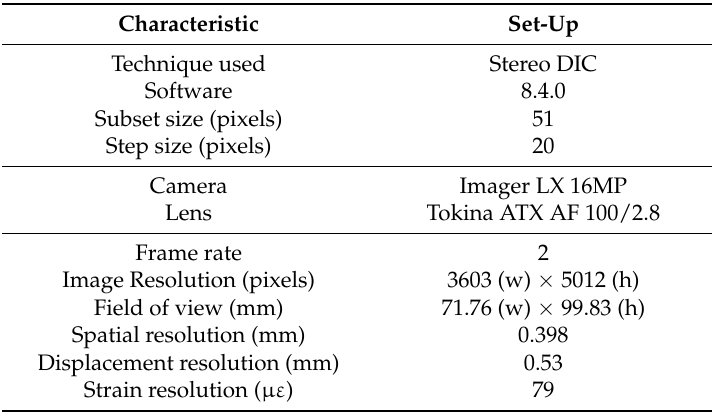
Table 3. Stereo DIC set-up and the processing parameters.